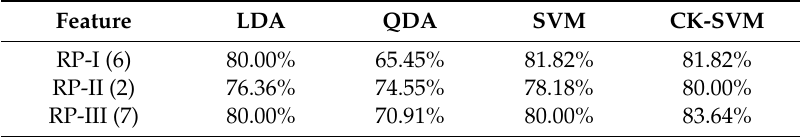
Table 3. Comparison of accuracy for different classifiers using data from the emotion-induction